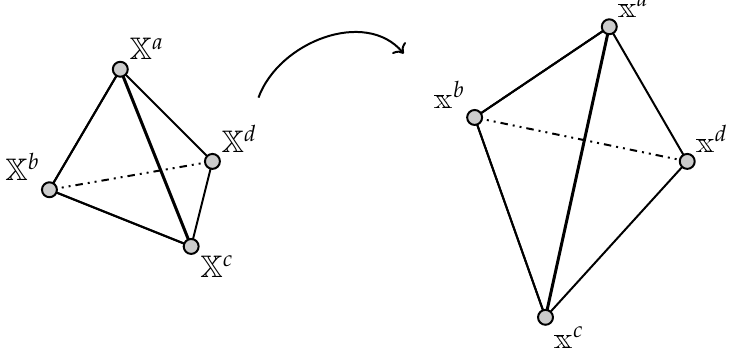
Figure 3. The deformation of a 3D tetrahedral